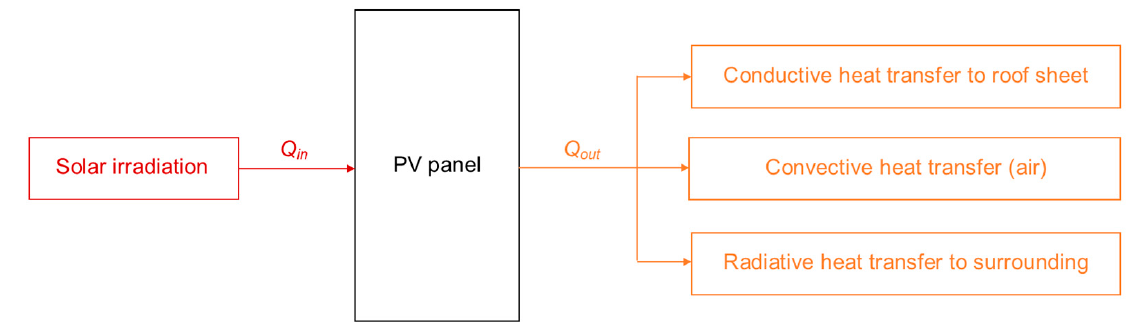
Figure 1. Thermal balance of the PV panels. The higher the module surface temperature, the higher short-circuit current, and the lower the open-circuit voltage. The negative effect of lowering the open-circuit voltage is dominant and consequently, this lowers the power of the PV panel compared to standard testing conditions [11]. The impact of temperature on the operating characteristic of PV panels is illustrated in Figure 2.